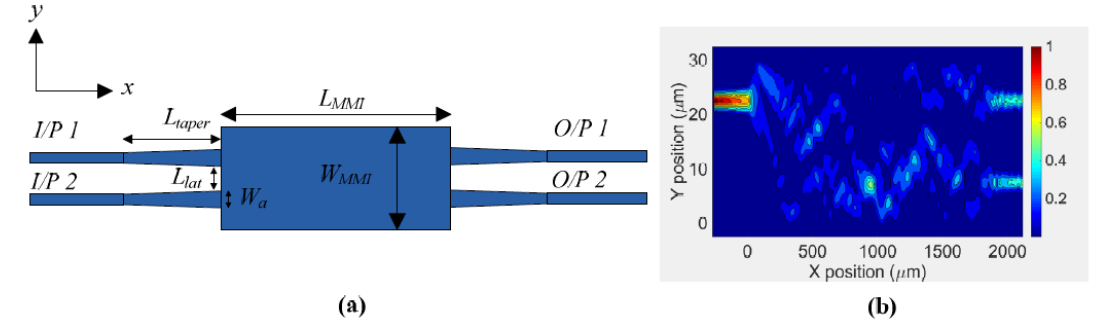
Figure 3. ( a ) Schematic of the 2 × 2 multimode interference (MMI) coupler with taper waveguide length, L taper = 200 µm and access waveguide width, W a = 5 µm and ( b ) the electric field distribution in a 2D plane of the MMI coupler at 1550 nm wavelength. Table 1. Simulation values of the power coupled to the two O/P waveguides of the MMI coupler. L MMI Percentage of the Input Input Power Coupled (µM) Power Coupled to the Two to the Two O/P O/P Waveguides Waveguides (dB) O/P 1 O/P 2 O/P 1 O/P 2 1850 42% 40% − 3.76 − 3.97 1860